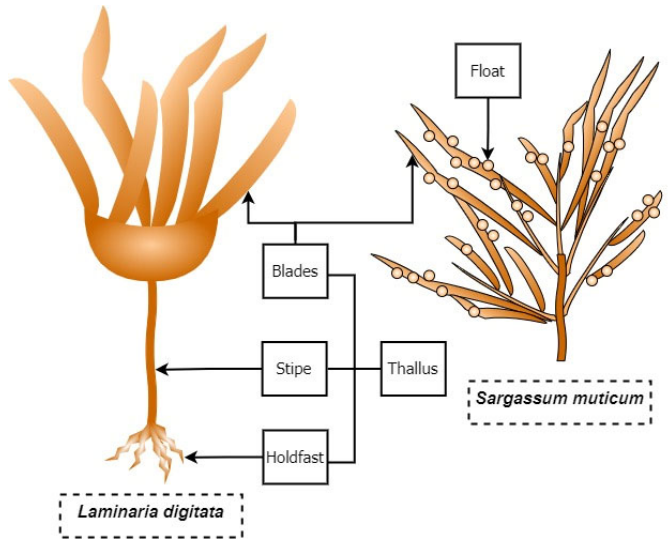
Figure 5. General morphology of brown seaweed (adapted from [55]).